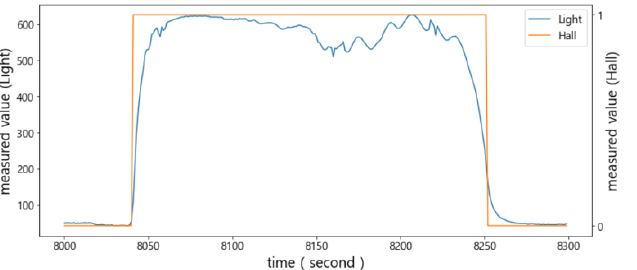
Figure 12. Determination of the opening and closing status of the door by combining the light sensor and the Hall sensor.